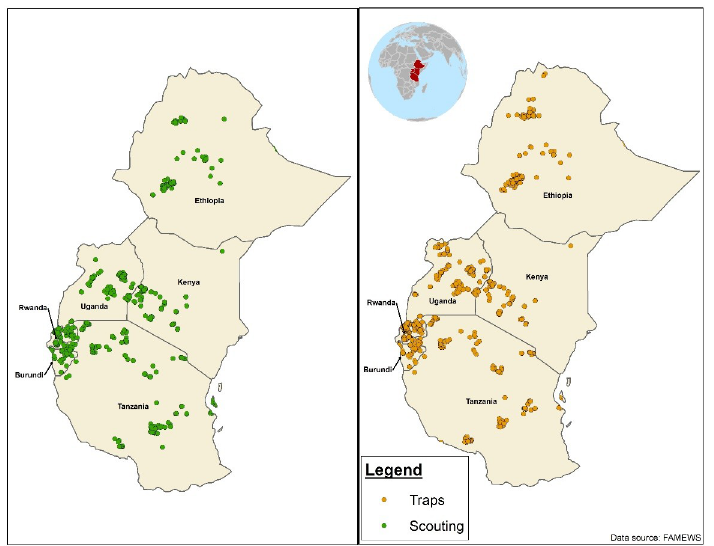
Fig 2. Fall armyworm sample locations of the installed traps for adults and scouted farms for larvae in six eastern African countries.